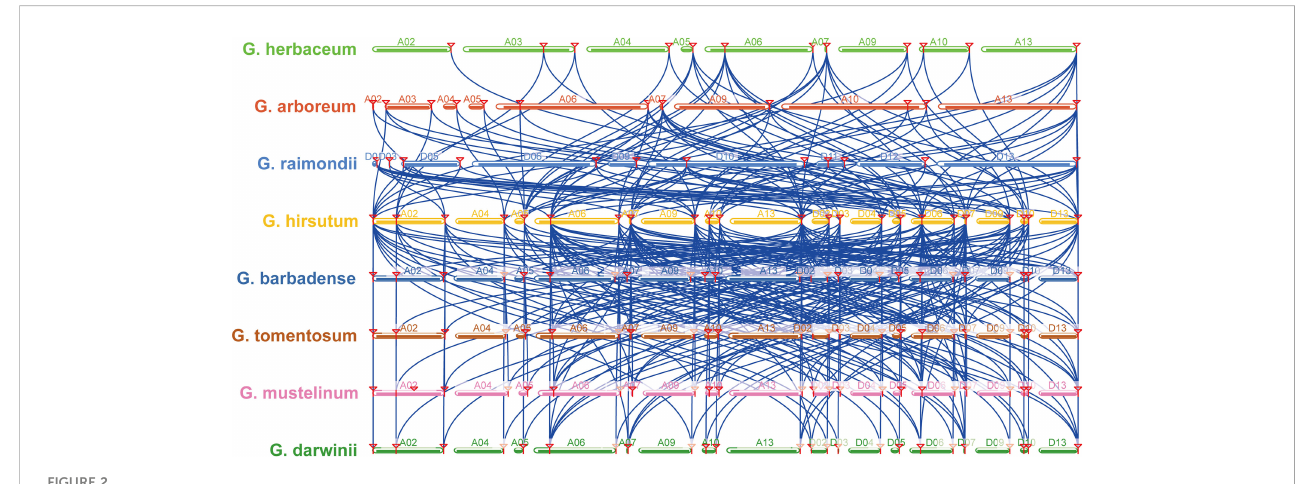
FIGURE 2 Multiple synteny analysis among cotton SAC genes. Multiple synteny analysis was used to show the orthologous relationship among G. herbaceum , G. arboreum , G. raimondii , G. hirsutum , G. barbadense , G. tomentosum , G. mustelinum , and G. darwinii SAC genes. Chromosomes of different cotton species were represented with different